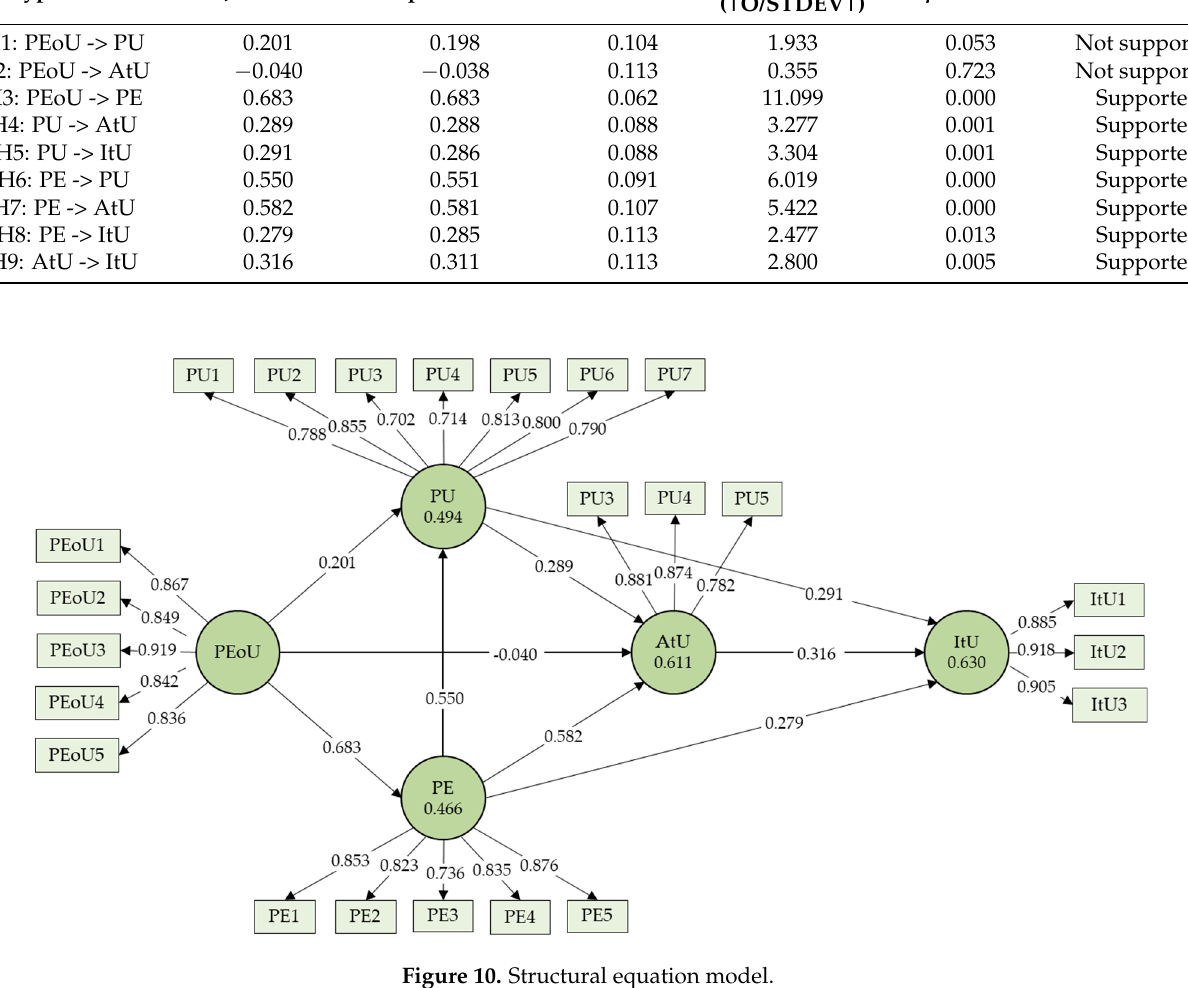
Table 8. Structural model results.